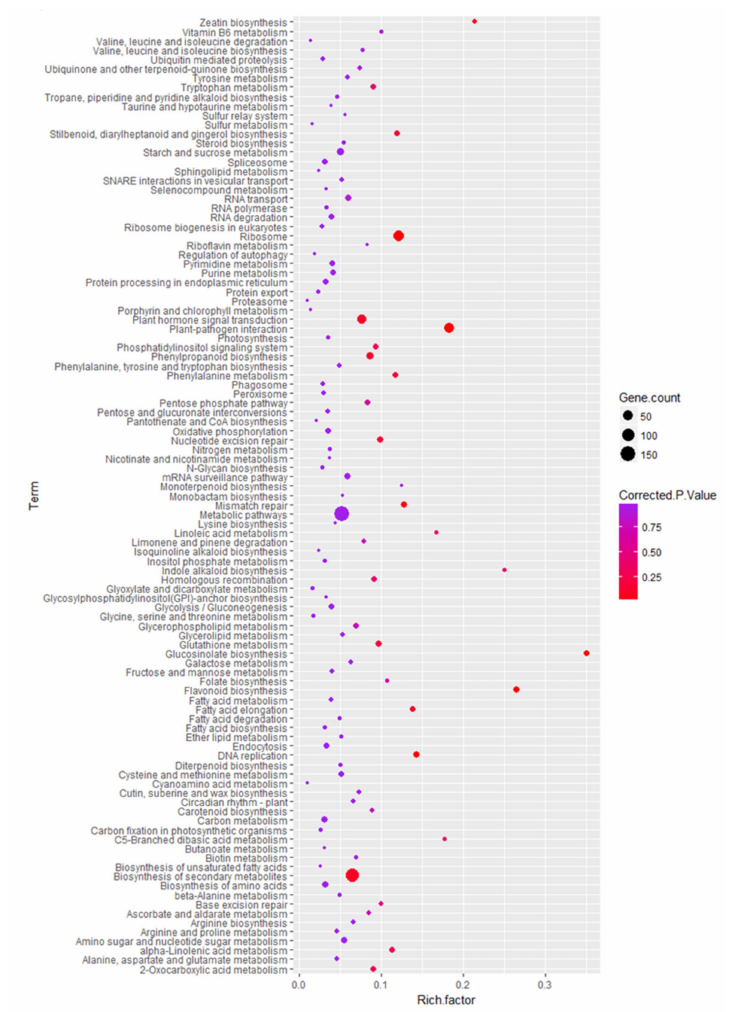
Figure 4. KEGG enrichment analysis of di ff erentially expressed anthocyanin biosynthetic genes. X -axis shows KEGG terms and y-axis shows enrichment factor. Gene count and corrected p -values are shown on